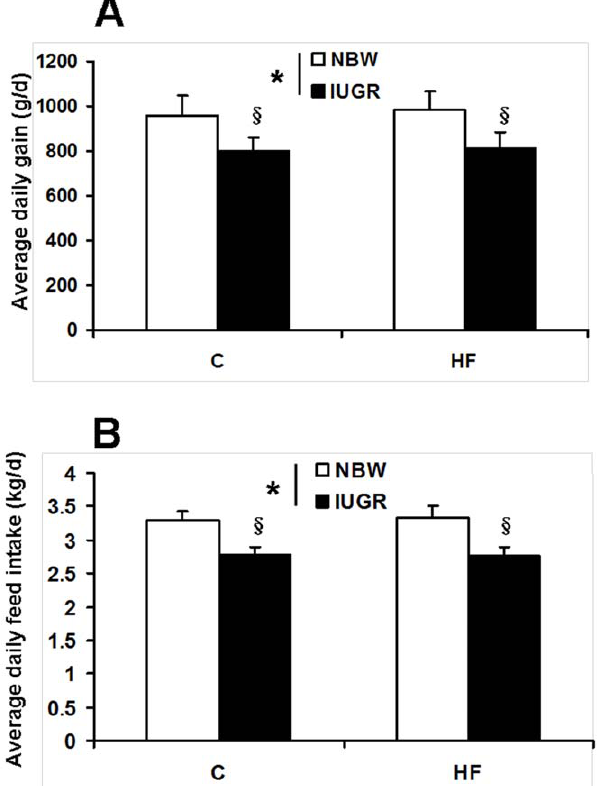
Figure 1. Influence of IUGR and diet on average daily gain (A) and feed intake (B) of pigs. C: Control diet; HF: High-fat diet; NBW: Normal birth weight; IUGR: Intrauterine growth retardation. Data are expressed as group means 6 SEM. * P values next to each label represent the significance in the effect for each source of variation (IUGR or diet) as calculated by ANOVA. 1 P , 0.05 in post hoc test comparing IUGR and NBW offspring receiving the same diet (n=8 by group).